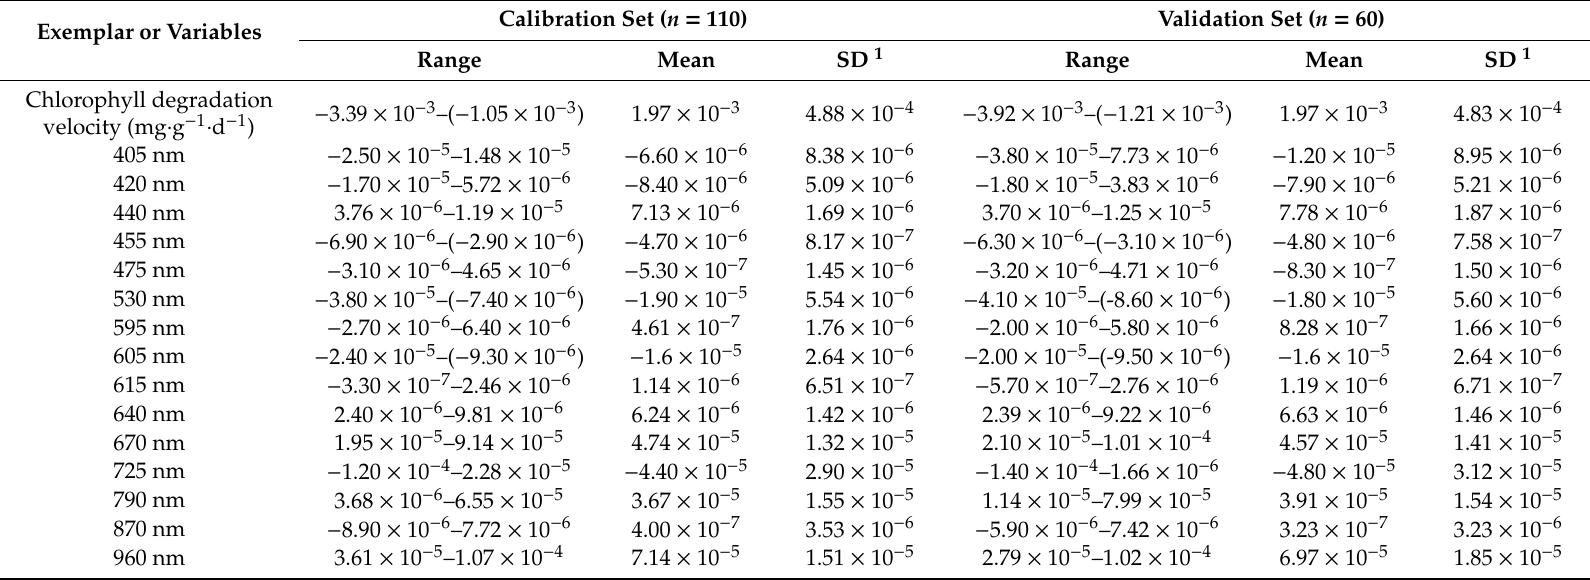
Table 1. Statistics of exemplar (chlorophyll degradation velocity of broccoli buds) and independent variables (second derivative of absorbance at chosen wavelengths) within calibration and validation